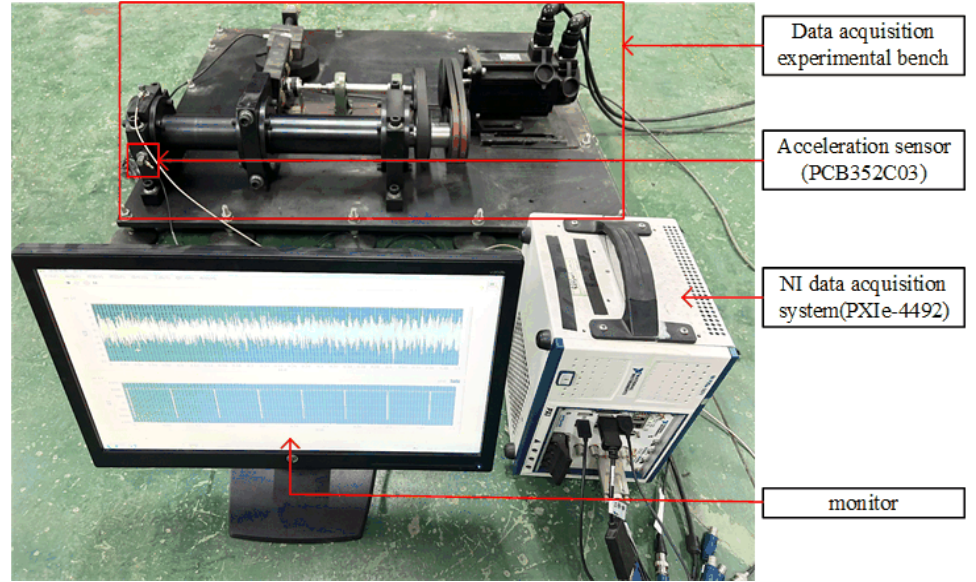
Figure 8. Testbed for bearing data acquisition.